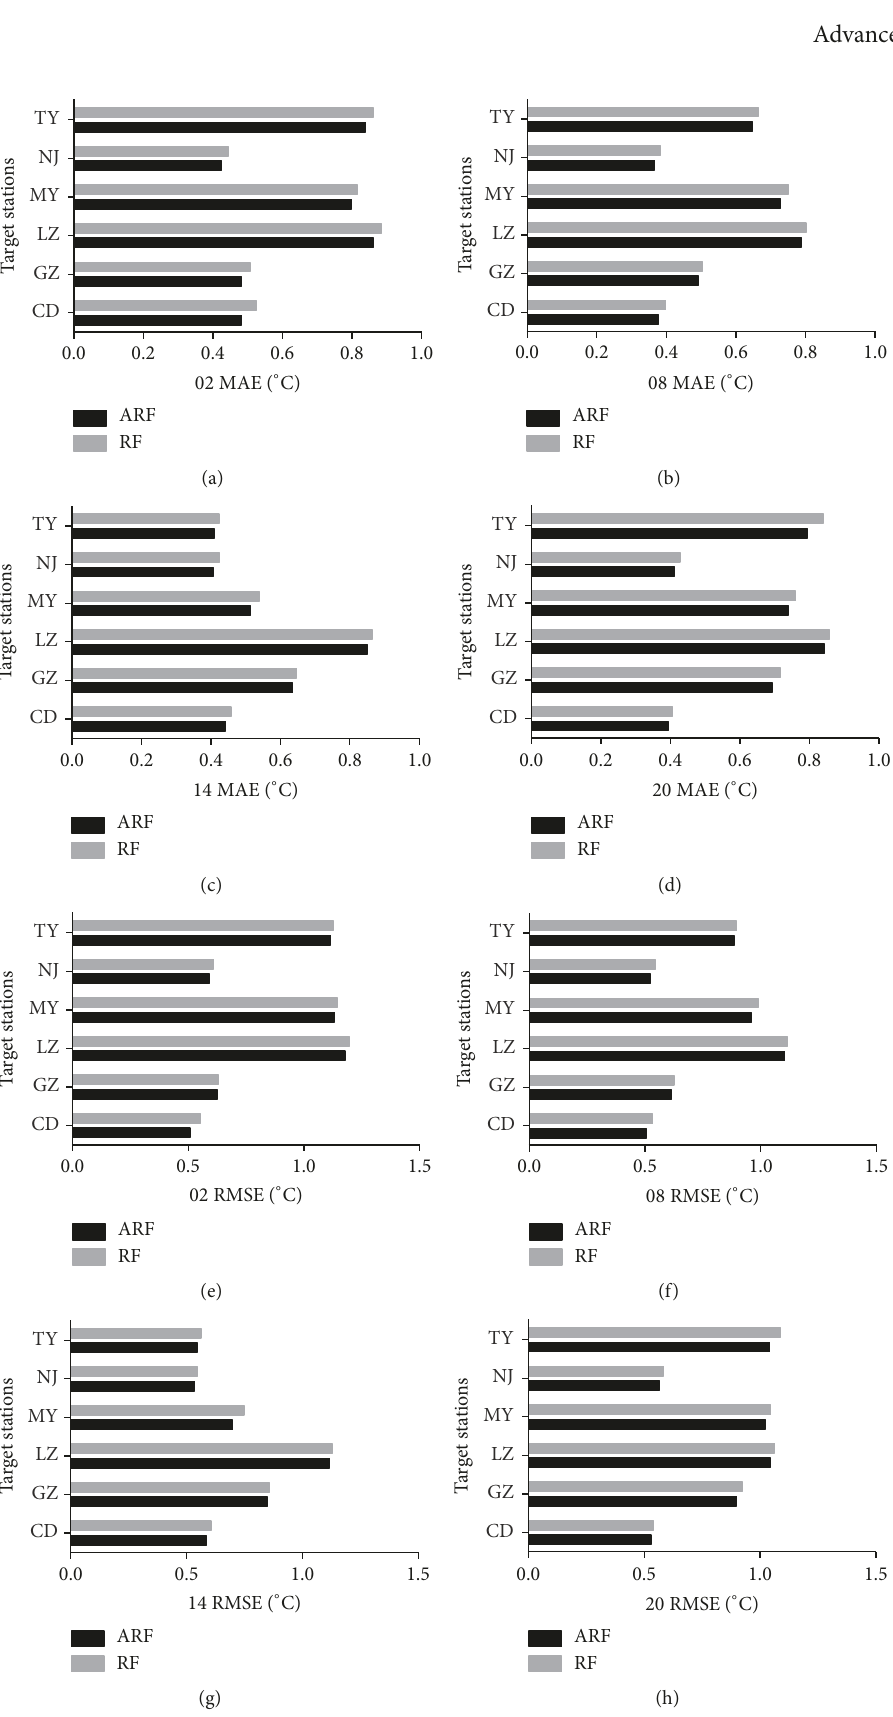
Figure 8: Comparisons of performance of the ARF and RF methods for different target stations: (a)–(d) the contrast condition of MAE at 02:00, 08:00, 14:00, and 20:00; (e)–(h) the contrast condition of RMSE at 02:00, 08:00, 14:00, and